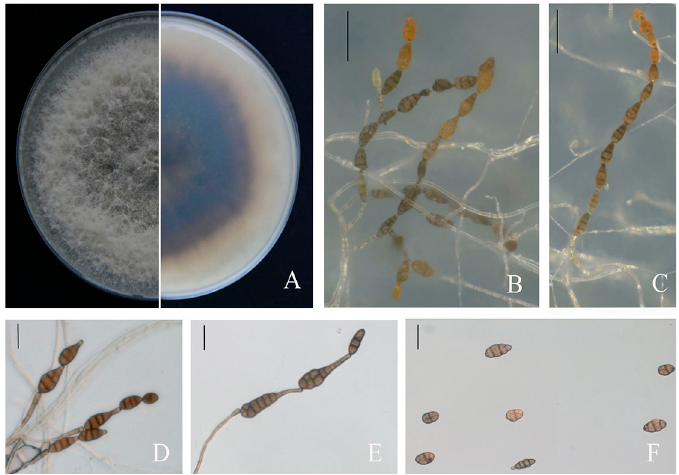
Figure 3. Morphological characters of A. alternata. ( A ) Front and back views of colony morphology on PDA after 7 days. ( B – E ) Conidiophores developed on SNA. ( F ) Conidia. Scale bars: ( B , C ) = 50 µ m; ( D – F ) = 20 μ m.